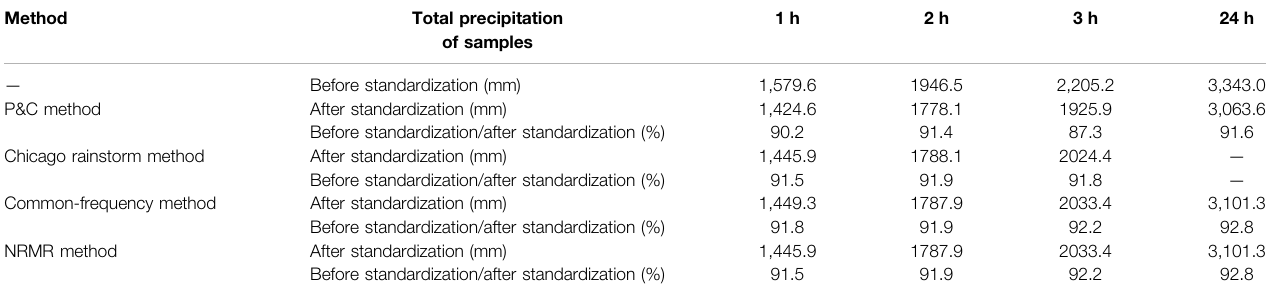
TABLE 2 | Comparison of total rainfall in test samples with different durations before and after the natural moving process. Method